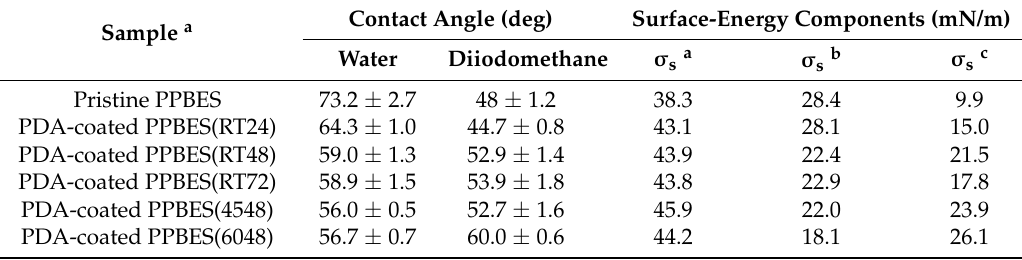
Table 1. Effect of Reaction Time and Temperature on the SE of PDA-coated PPBES.